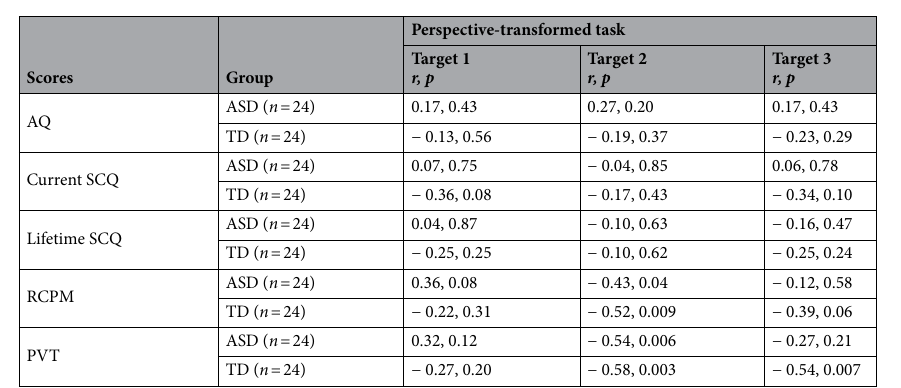
Table 3. Correlations between endpoint bias and questionnaire scores. No significant correlations were found after false discovery rate correction. r : correlation coefficient; ASD: autism spectrum disorder; TD: